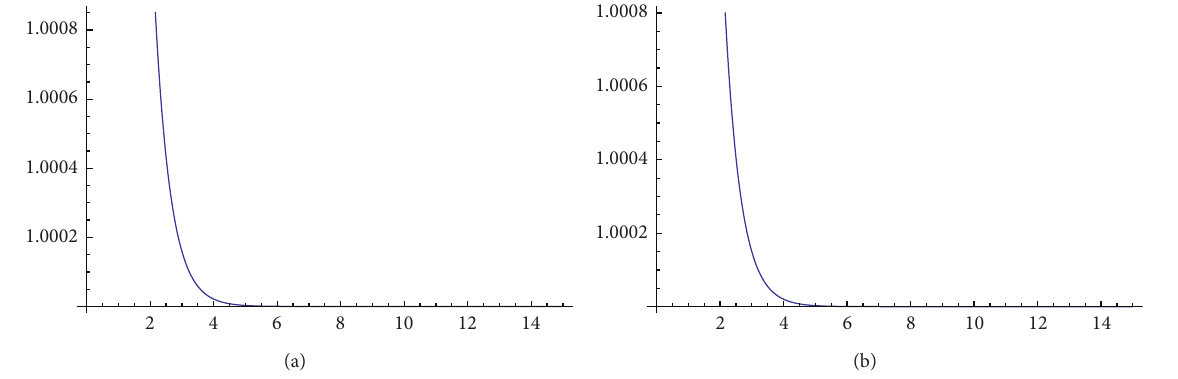
Figure 10: Two-dimensional graph of the solution (37) corresponding to the values 𝛼 = 0.05 , 𝛼 = 0.85 , respectively, when 𝑘 = 1 , 𝑝 = 2 , 𝛽 = 3 , 𝑡 = 1 , and 0 < 𝑥 < 15